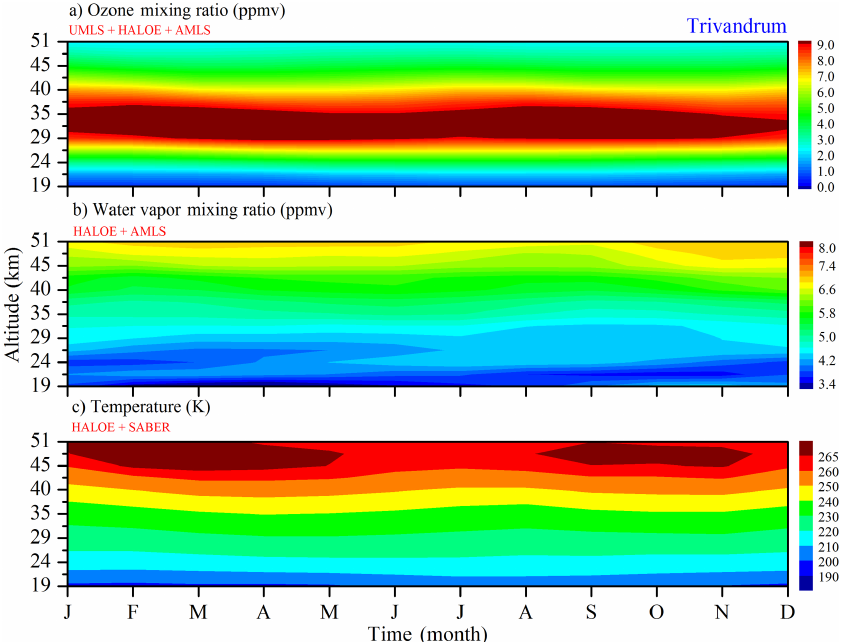
Figure 5. Composite monthly mean contours of bias removed (a) ozone mixing ratio contour constructed using UMLS (1993–199),